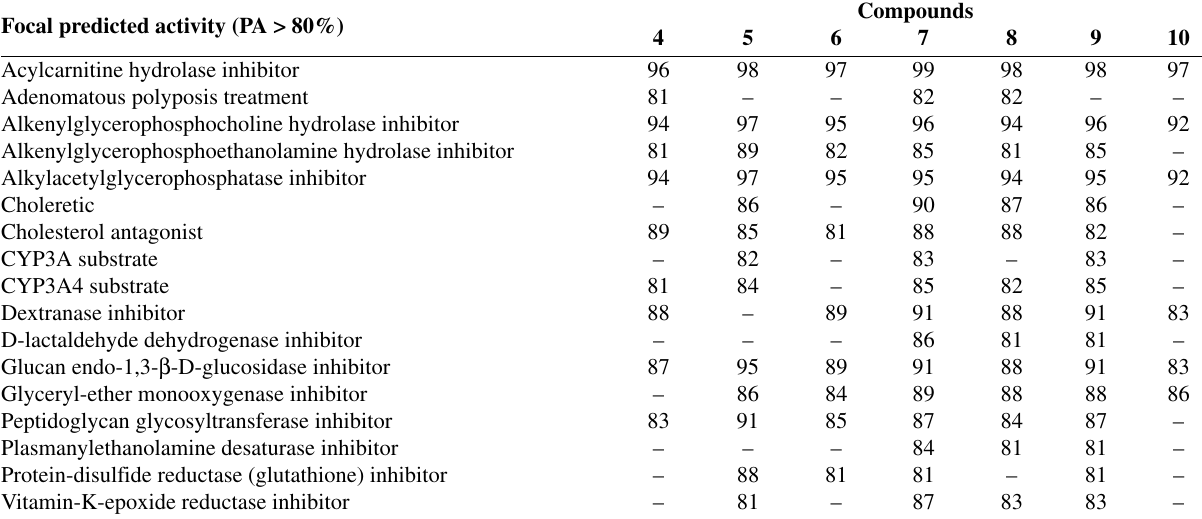
Table 2. Probability »to be Active« (PA) values for predicted biological activity of compounds 4 – 10 . Focal predicted activity (PA > 80%)